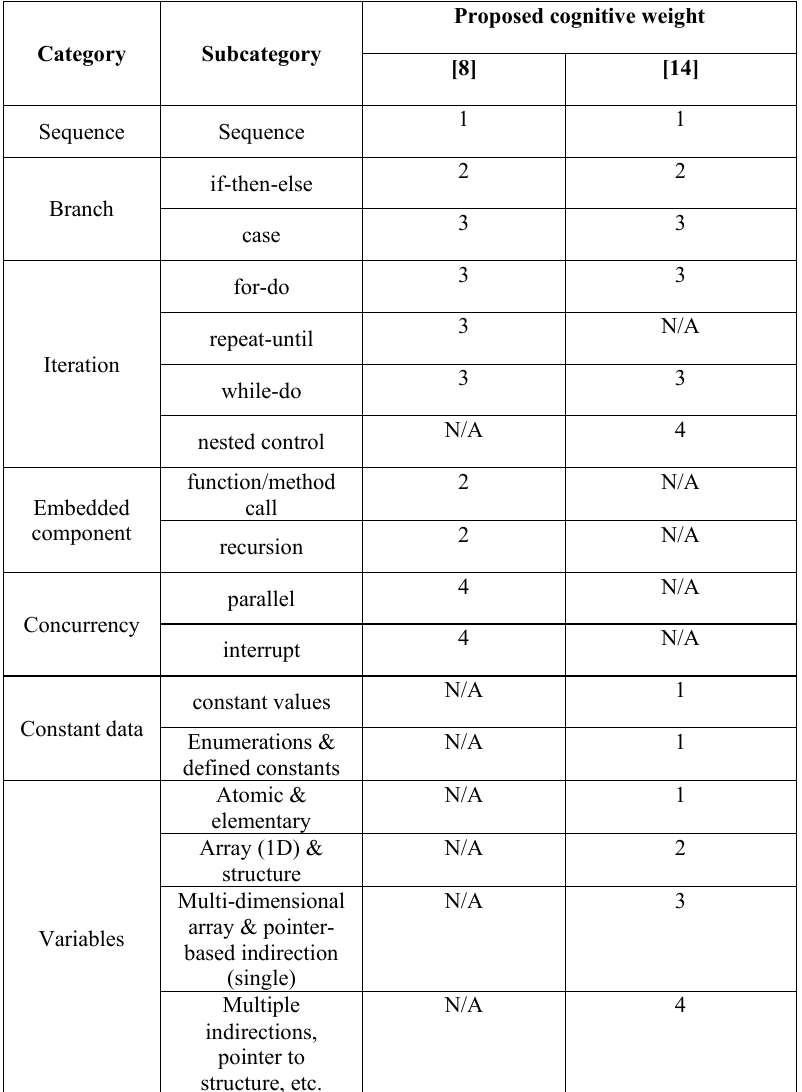
Table 1. Cognitive weights for functional programming source codes [8,